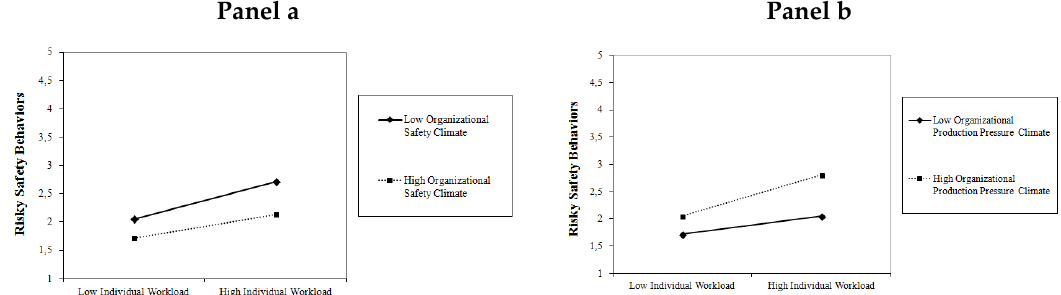
Figure 2. Plots of Cross-Level Interactions from the Final Multilevel Model.